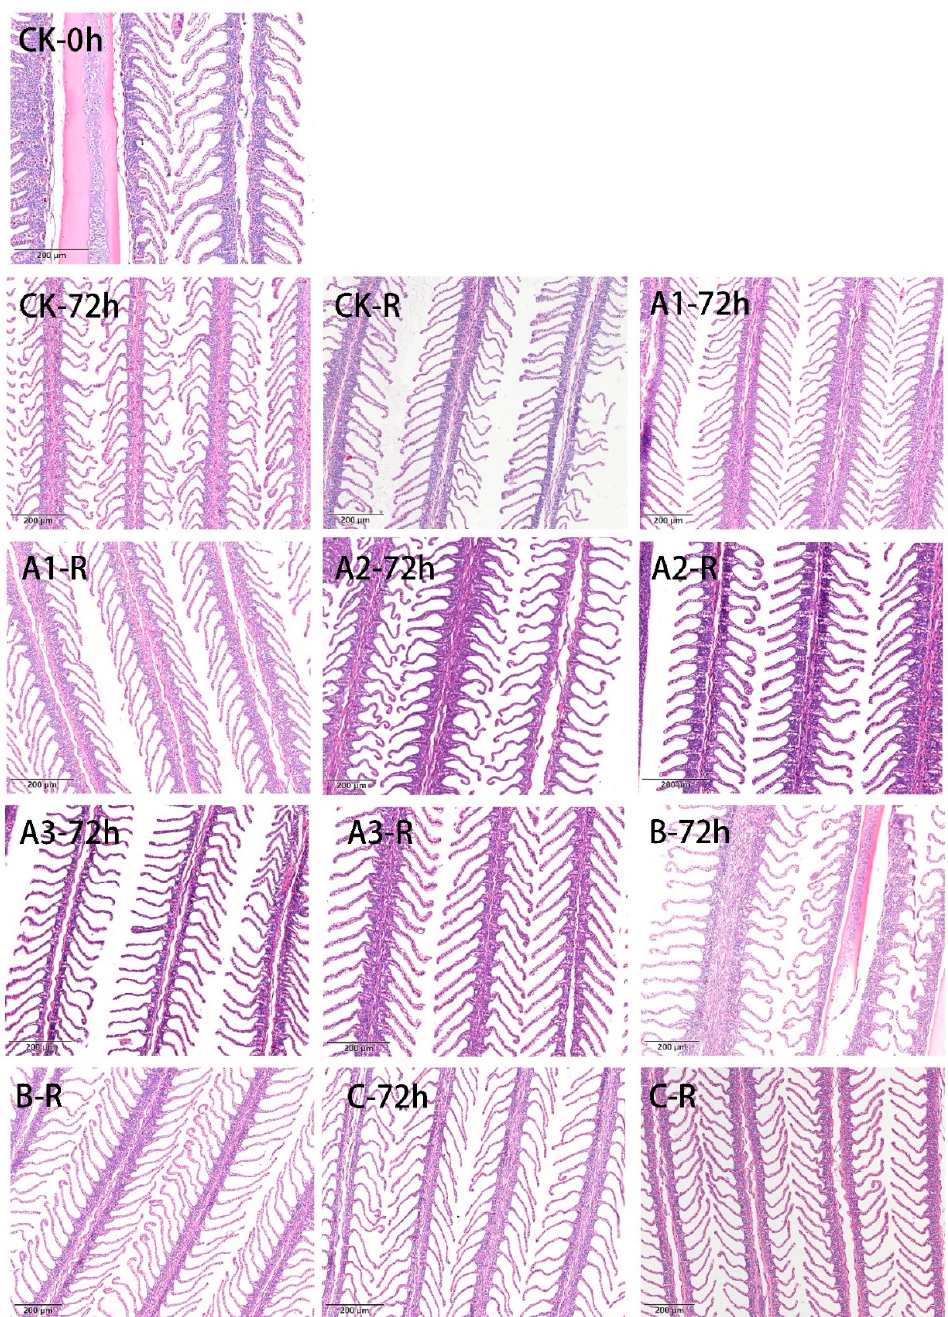
Figure 1. Representative H&E stained sections micrographs of the effect in different treatments on the gill structure of sea bass during keep-alive transportation. A1: 10 mg/L MOEO, A2: 20 mg/L MOEO, A3: 40 mg/L MOEO, B: 30 mg/L MS-222, C:20 mg/L eugenol, CK: no sedative of anaesthetic addition. After 72 h exposure or 12 h after recovery (R), other groups were also represented in this way.